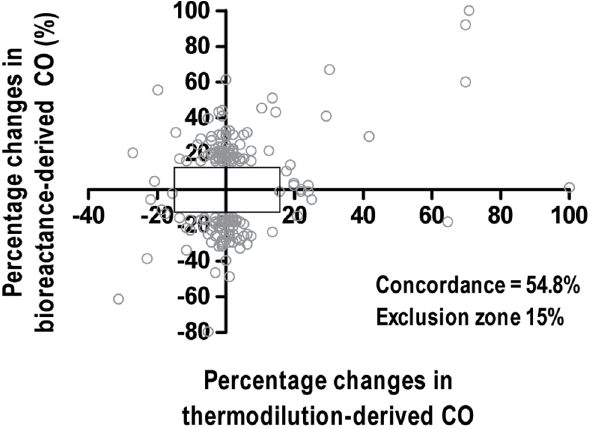
Fig 3. Four-quadrant concordance analysis between the changes in cardiac output (CO) measured by bioreactance and thermodilution. The zero-centered square corresponds to the 15% exclusion zone.